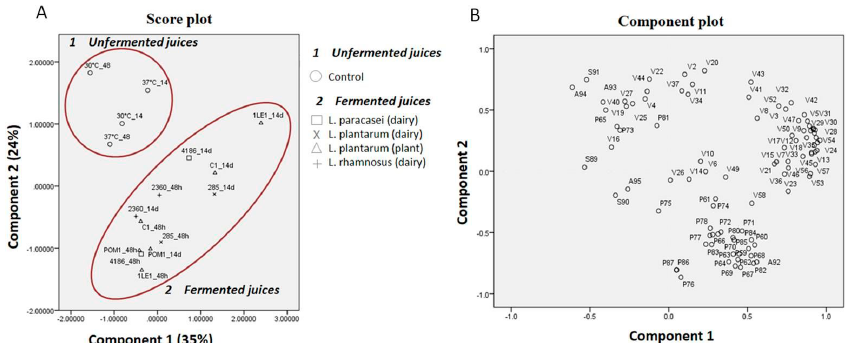
Figure 1. Principal component analyses. ( A ) Score plot obtained from the analysis of unfermented (control) and fermented ( L. plantarum , L. rhamnosus and L. paracasei ) cherry juice. Each sample is identified by the strain number and the time of incubation. For example, 1LE1_48h is used for strain L. plantarum 1LE1 after fermentation. ( B ) Loading plot is based on sugars, organic acids, and volatile and phenolic compounds. Abbreviations are the same as used in Table S1 for organic acids (A) and sugars (S), Table S2 for volatile compounds (V), and Table S4 for polyphenols (P).